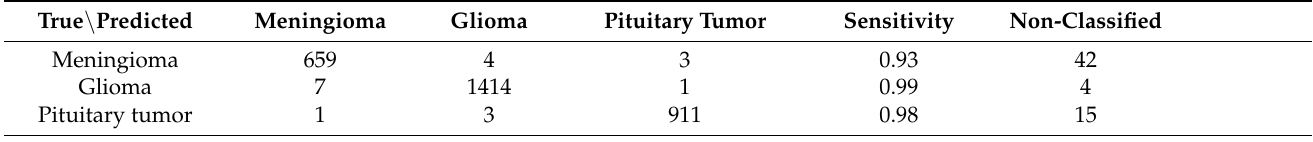
Table 3. Confusion matrix of the predicted tumor for our method. The number of non-classified images is 61 (42/4/15), taking a confidence threshold τ c = 0.75. The tumor type precision (tumor classification accuracy) achieved ( ∑ diag/ ∑ total) is 0.973.